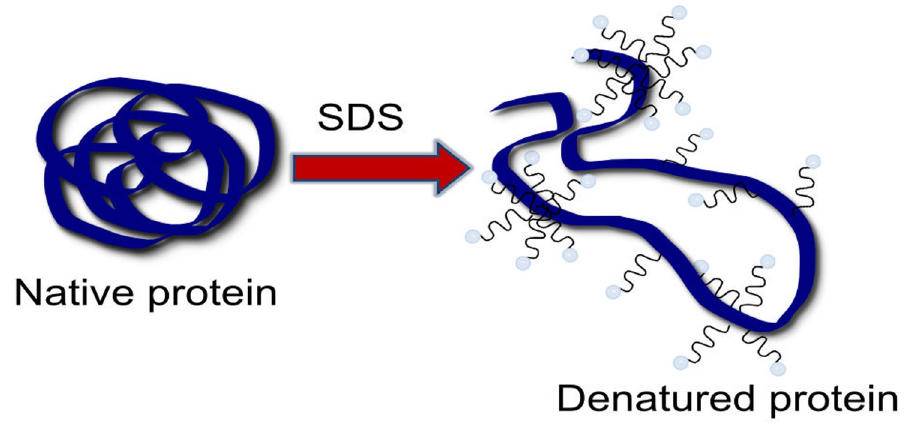
Fig 1. Schematic description of denaturation of proteins by